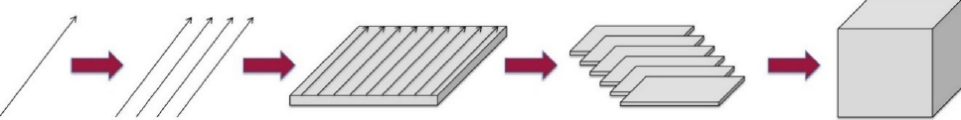
Figure 9. Flowchart describing SLM processing from a single laser track to the 3D object [12].